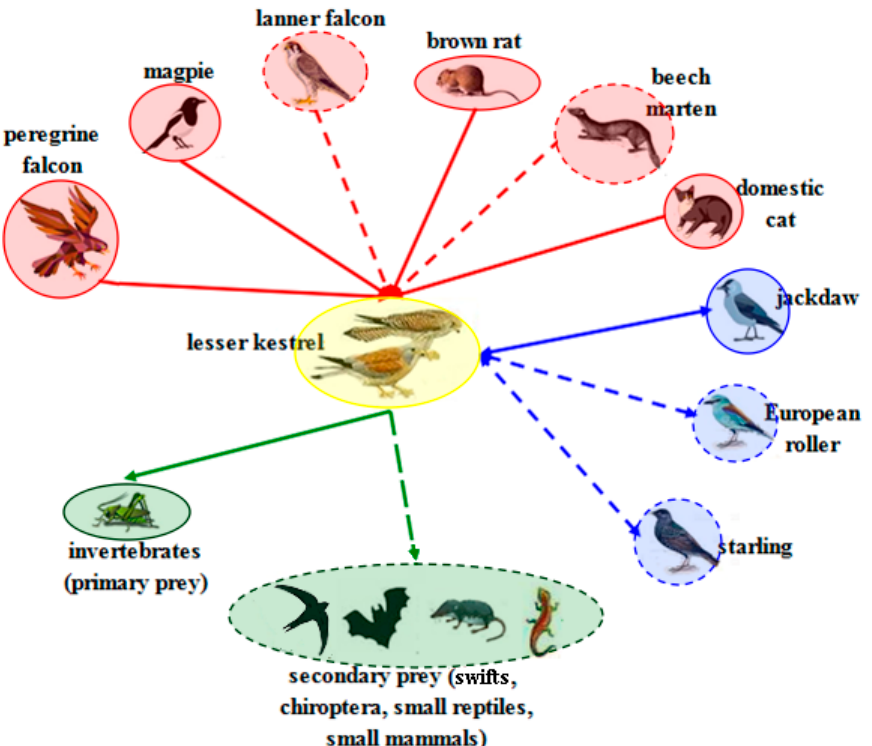
Figure 2. The biotic community of the lesser kestrel in the study area. The red, blue, and green arrows indicate the predators, the competitors, and the prey, respectively. The solid lines indicate frequent interactions and the dashed lines indicate infrequent interactions.